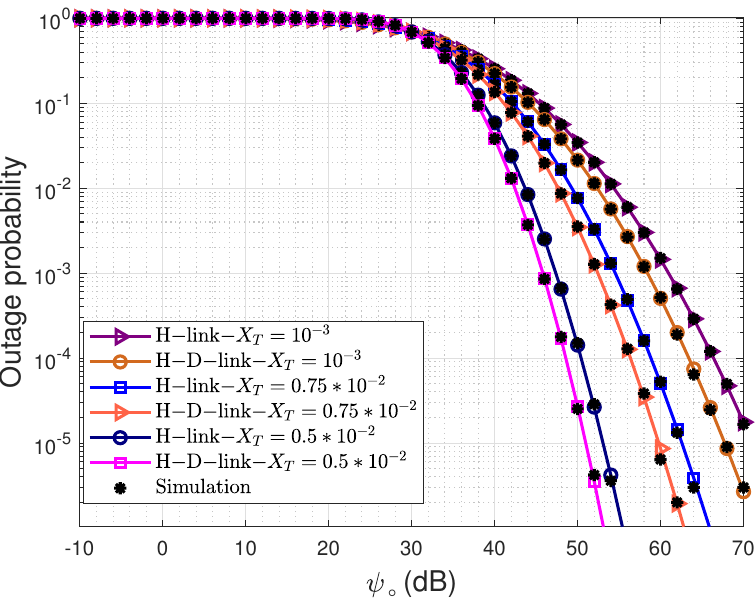
Figure 4. Outage probability ( P o ) versus average SNR ( ψ ◦ ) dB for different dissipation rates of mean square temperature ( X T